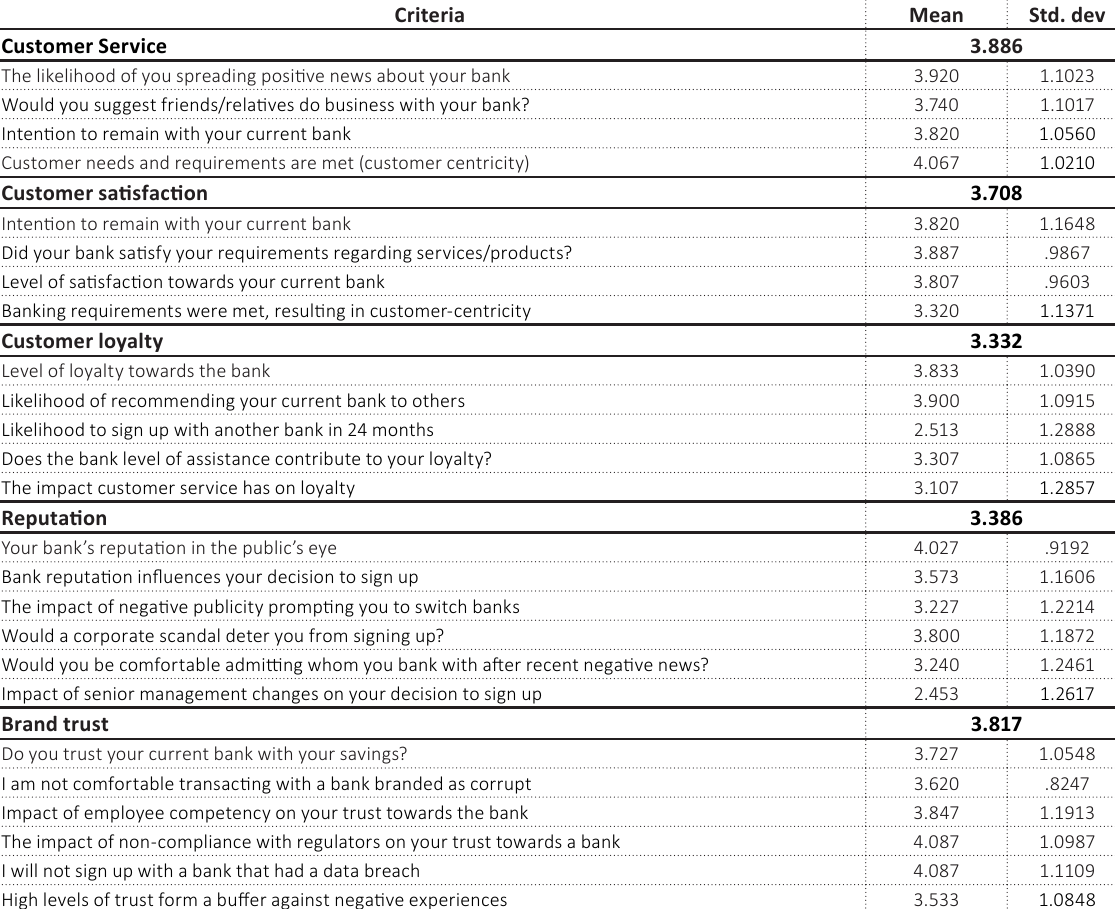
Table 2 . Brand loyalty antecedents in banking